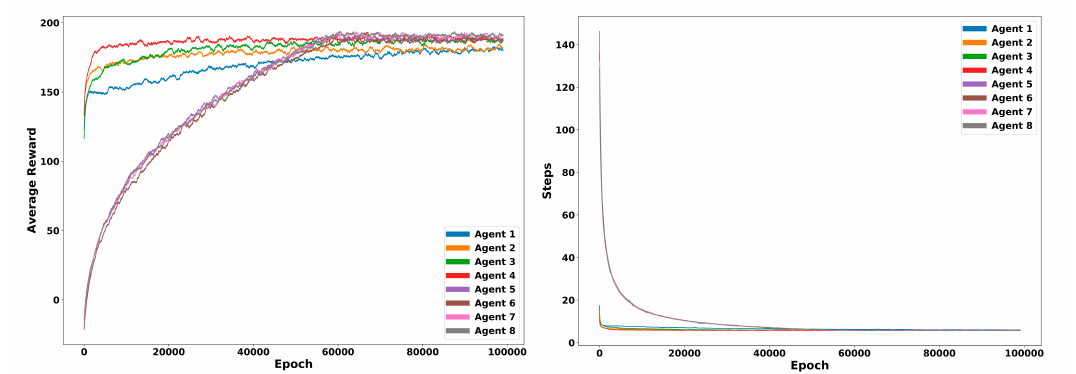
Figure 6. Total reward on episode averaged over 5 different runs for eight different agents ( left ) and the total number of steps averaged over these runs ( right ) using Reward Shaping I. The training of each agent comprised 100,000 episodes and curves are smoothed with a window of 1000 epochs.